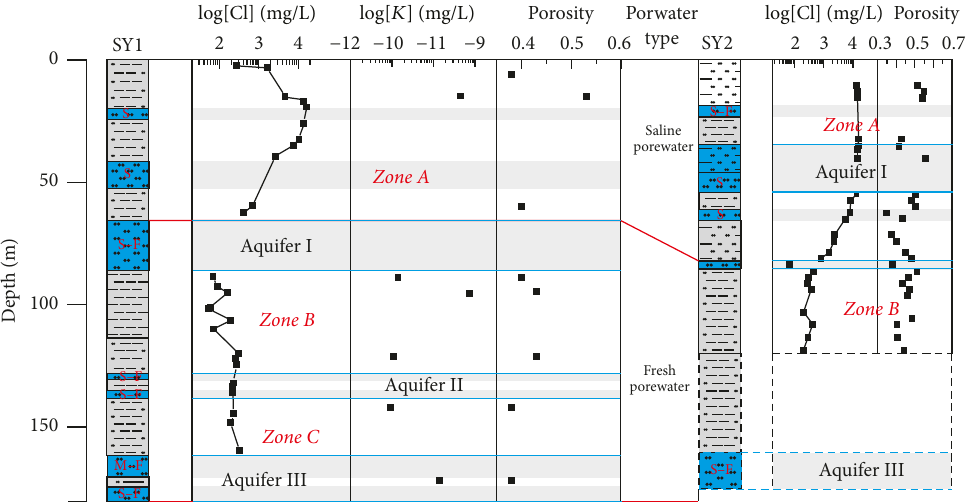
Figure 4: Geologic profiles and hydrogeologic zones, the measured Cl − concentrations, hydraulic conductivity, porosity versus depth, and porewater types. The black dotted bordered rectangles represent the sediments that were not revealed in the borehole SY2.